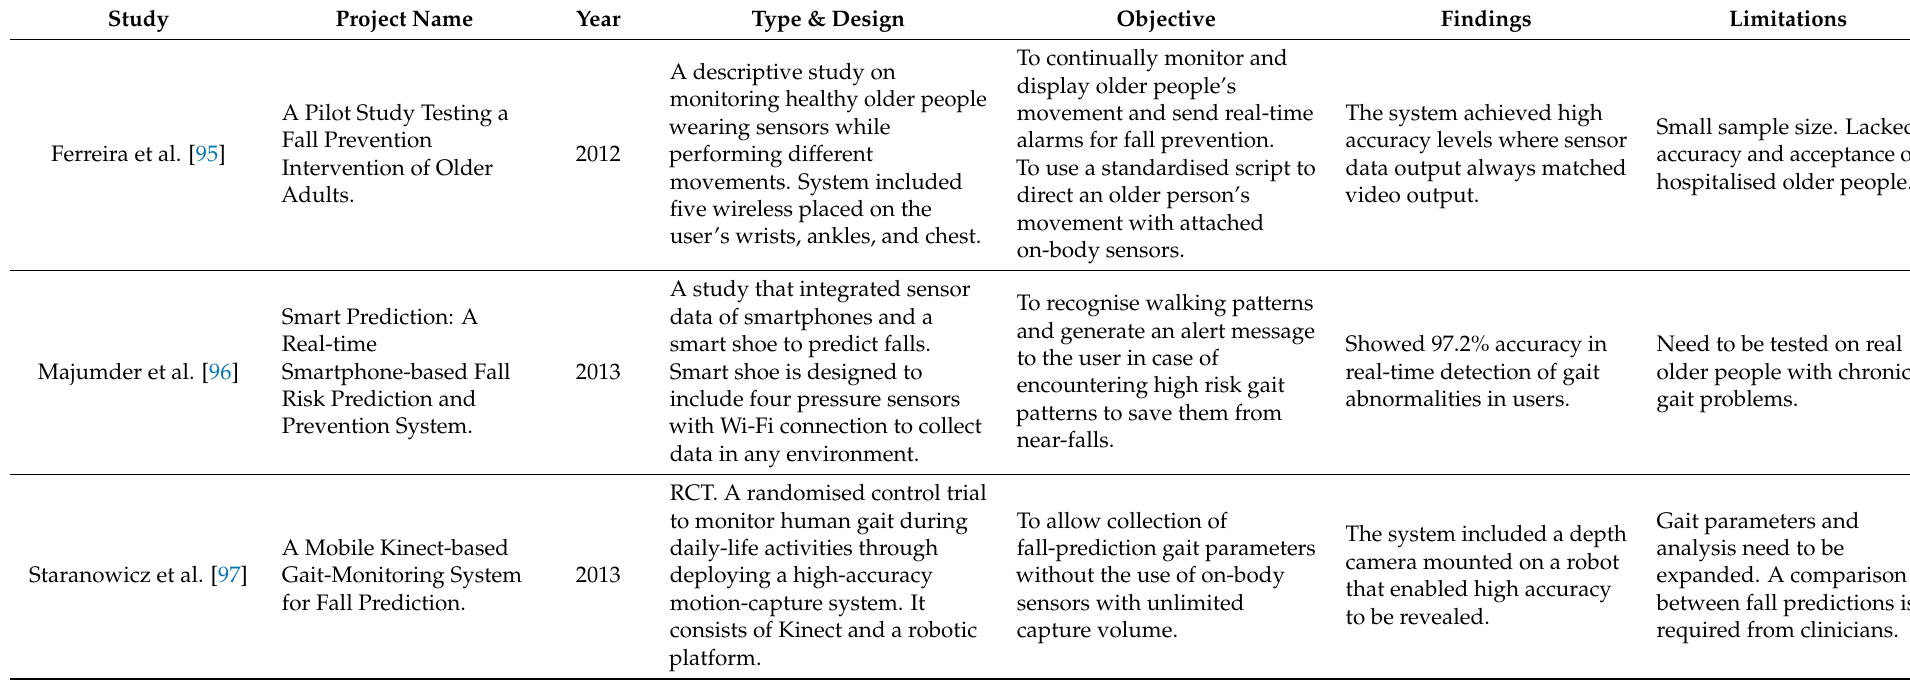
Table 7. ICT solutions for fall prediction systems for assistive living of older